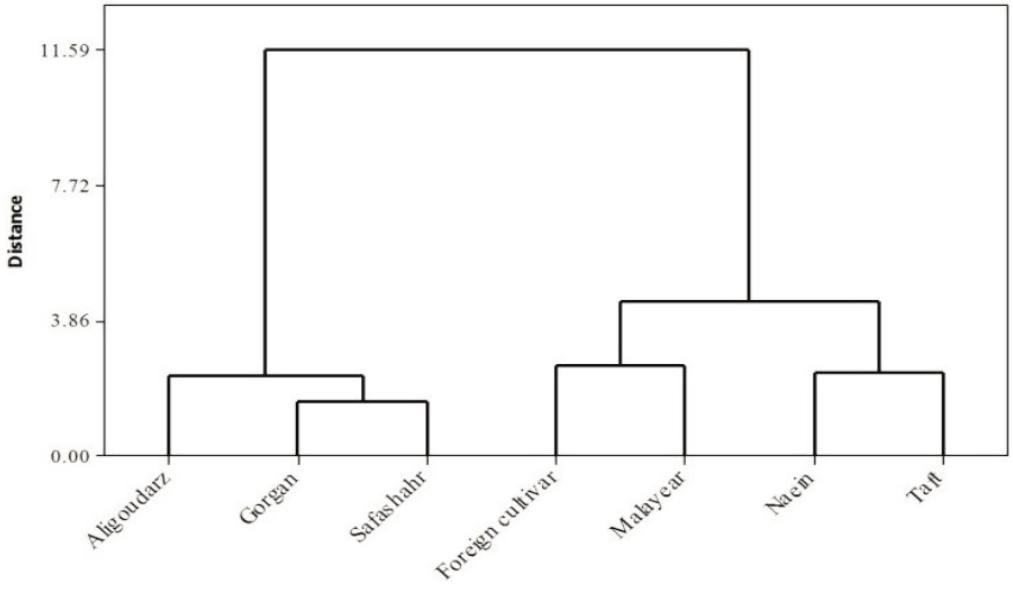
Fig. 5 - Dendrogram of the physiological relationships between 7 cold-tolerant accessions of common bermudagrass after cold stress at -15/-15 °C day/night